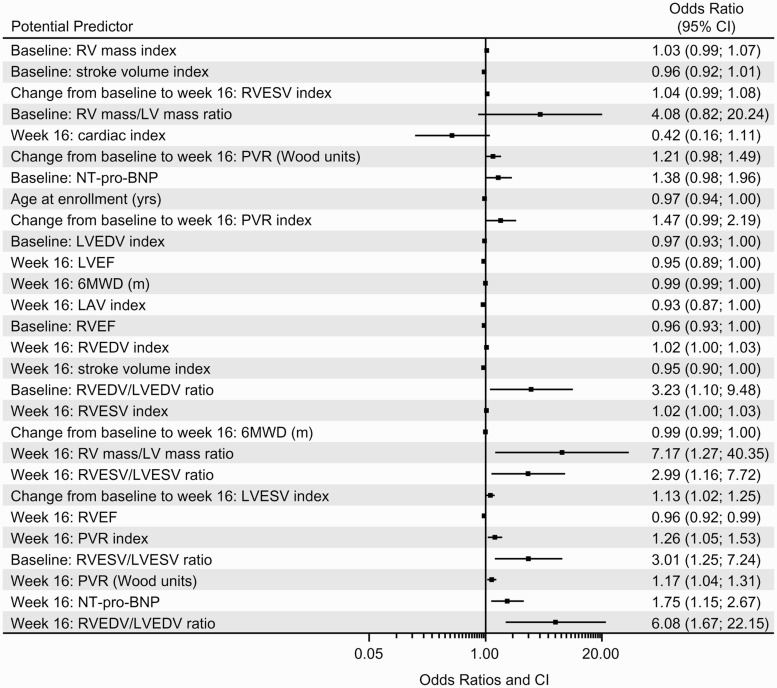
ORs from univariable analyses of baseline parameters for clinical worsening and/or decline. 6MWD, 6-min walk distance; CI, confidence interval; LAV, left atrial volume; LV, left ventricular; LVEDV, left ventricular end diastolic volume; LVEF, left ventricular ejection fraction; LVESV, left ventricular end systolic volume; NT-pro-BNP, N-terminal pro-B-type natriuretic peptide; PVR, pulmonary vascular resistance; RV, right ventricular; RVEDV, right ventricular end diastolic volume; RVEF, right ventricular ejection fraction; RVESV, right ventricular end systolic volume.